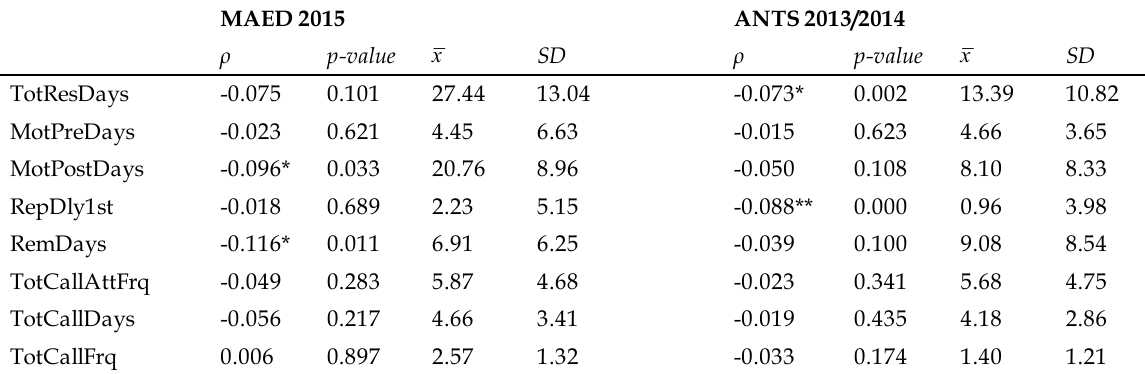
Table 3. Impact of response effect on trip